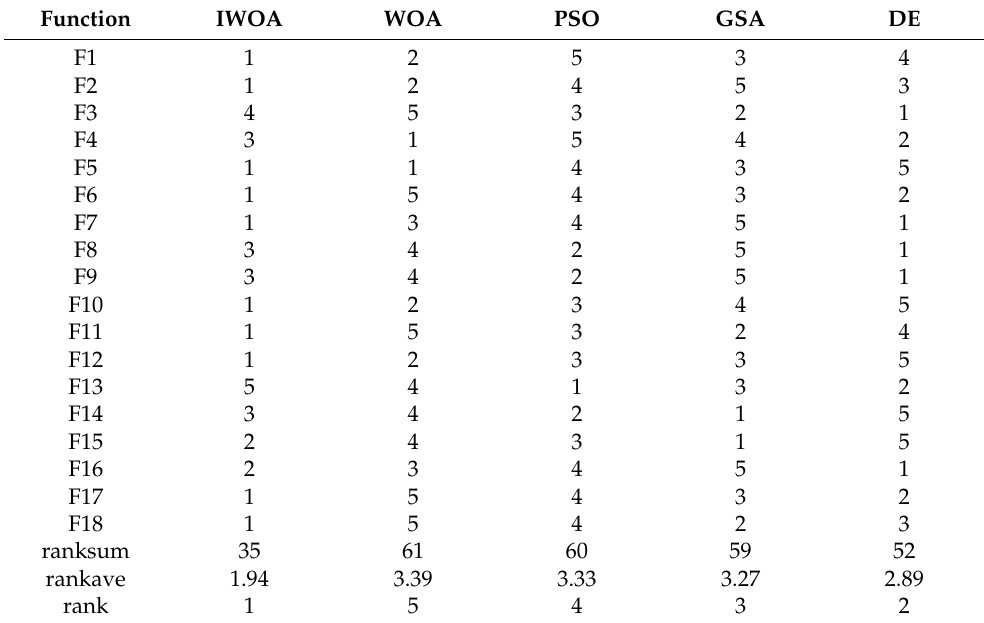
Table 3. Algorithm performance